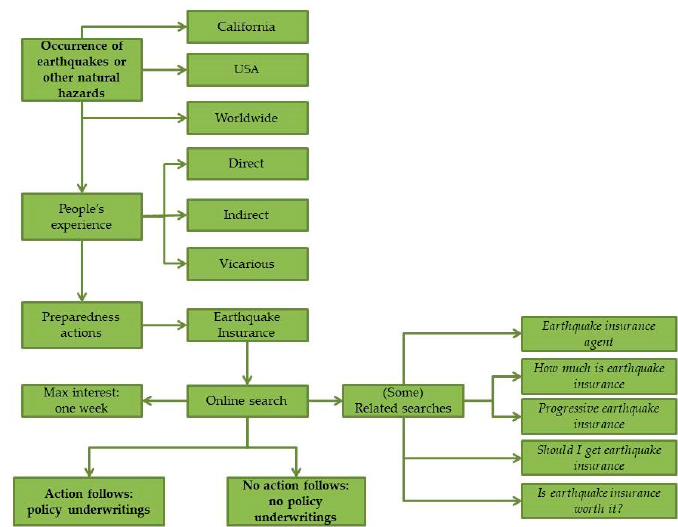
Figure 9. Possible operative flow for internet users interested in earthquake insurance.